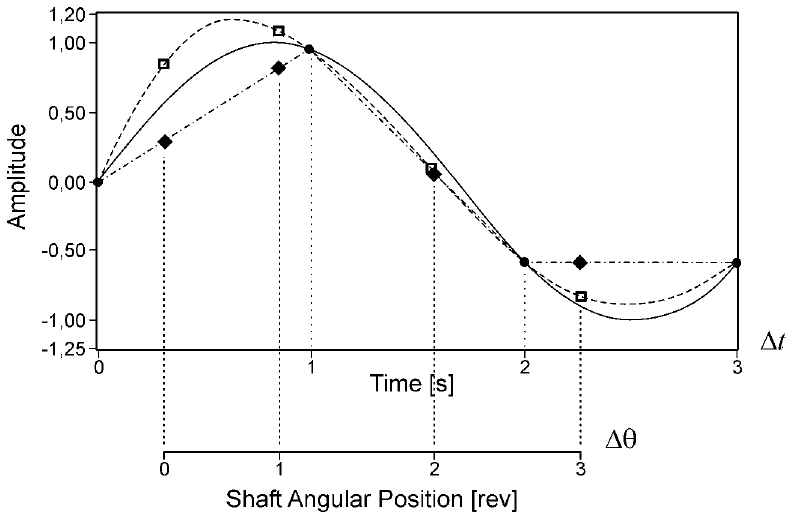
Fig. 5. Determination of the amplitude of the resampled signal. Key: (cid:2) = linear interpolation, (cid:3) = cubic spline interpolation, and • = sampled data. These two problems were evaluated using the following two